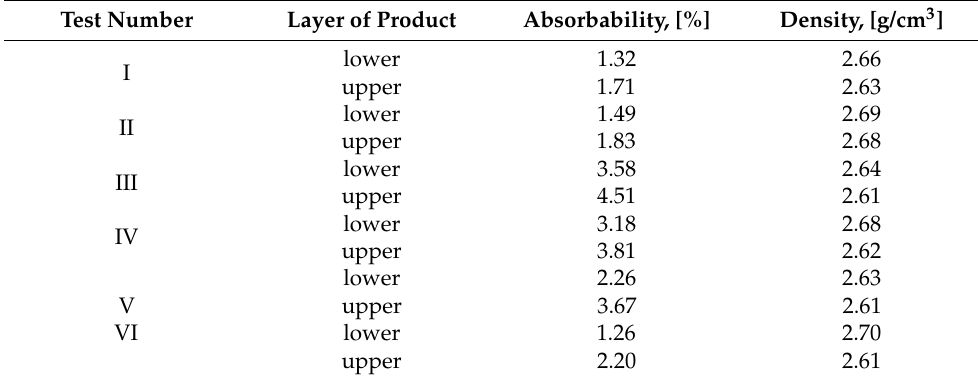
Table 7. Summary characteristics of individual tests in separator SET (high